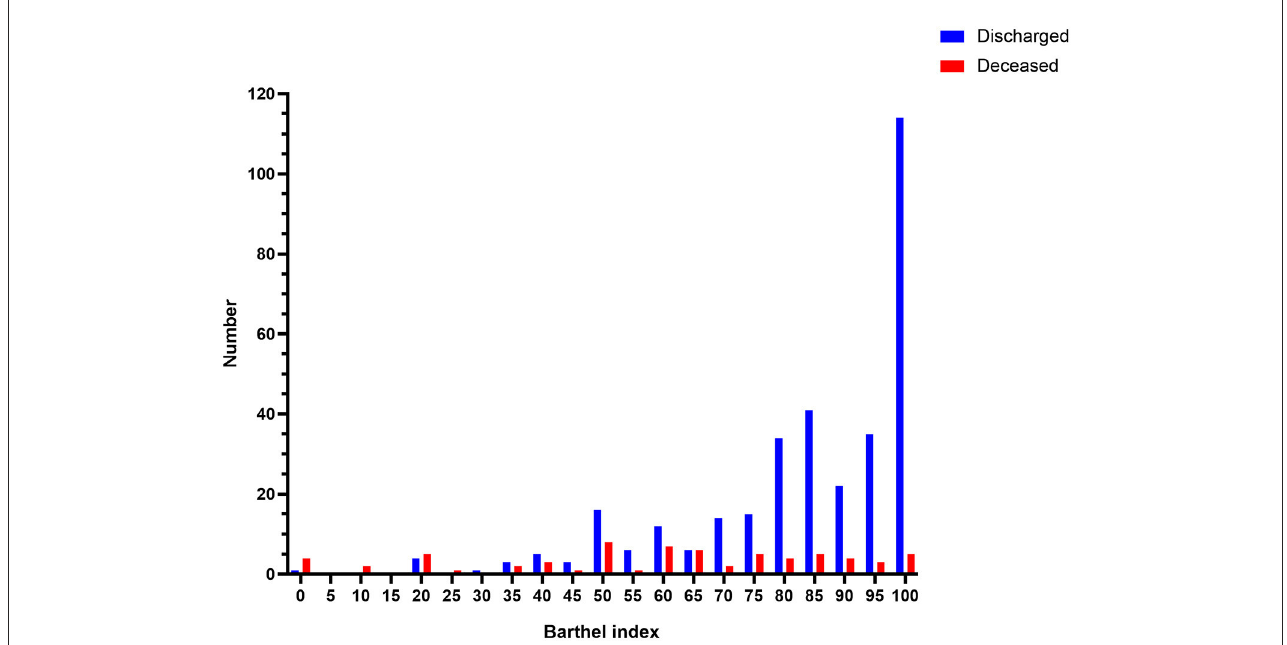
FIGURE2 The distribution of the Barthel Index in the deceased and the discharged patients. The histogram shows the obvious difference in the distribution of the Barthel Index between the deceased and discharged patients. Deceased patients are presented on the ( Right ), while discharged patients are presented on the ( Left